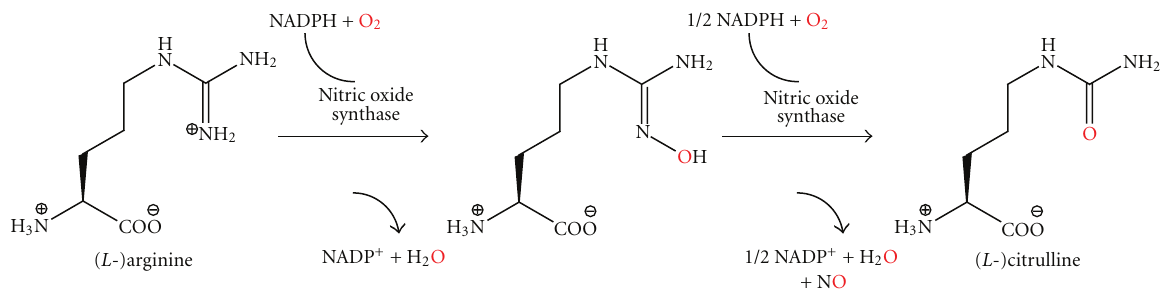
Figure 3: Biosynthesis of NO from ( L )-arginine